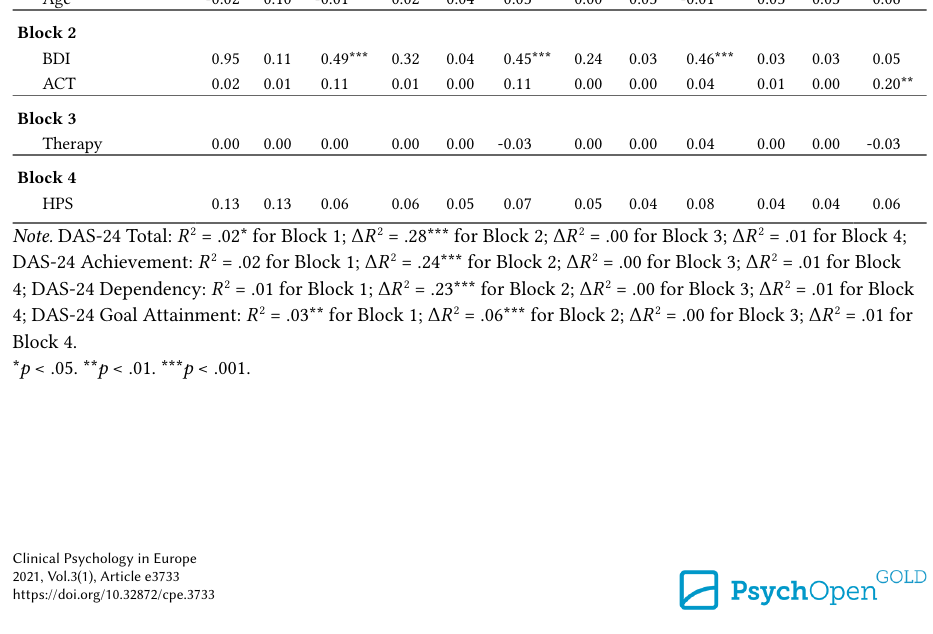
Final Model (Step 4) of the Hierarchical Regression Analyses for Cognition Related to Depression Predictor